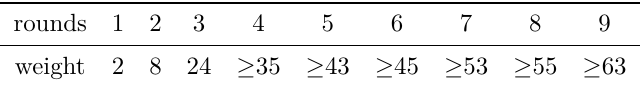
Table 4: Lower bounds on the weight of differential trails for tweak schedule. Note that the order of rounds is the same as depicted in Figure 2.